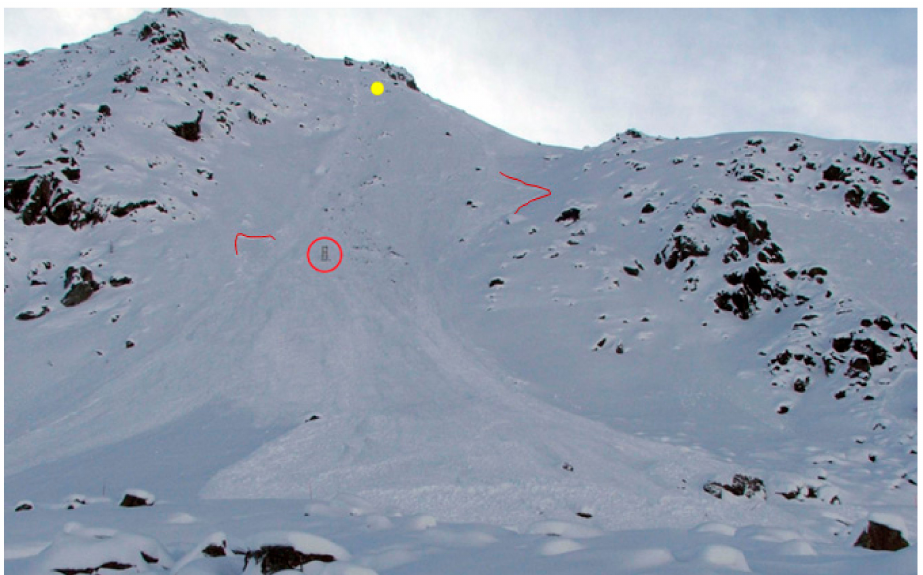
Figure 3. Overview of the 7 December 2010 avalanche. The yellow dot indicates the triggering point and the red circle the obstacle; the red lines highlight the secondary releases. Photo L. Pitet.